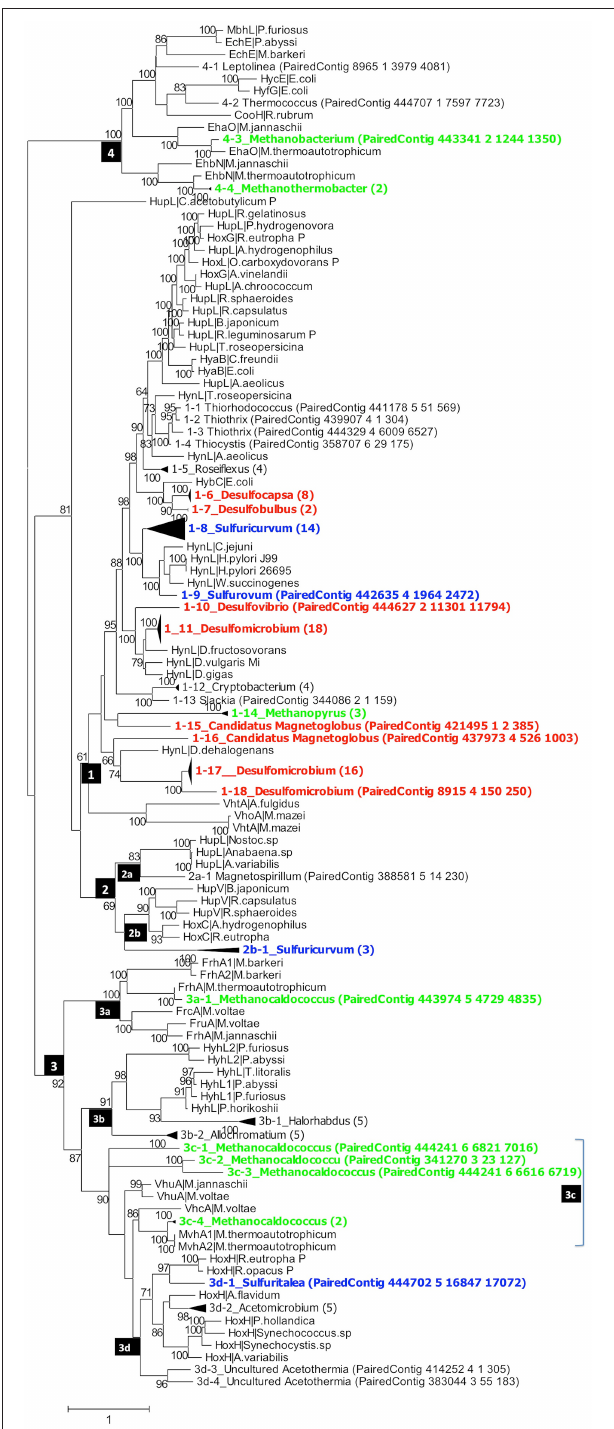
FIGURE 3 | Phylogenetic analysis of putative hynL genes for the large subunit of [NiFe]-hydrogenase detected in the PAS-821TP metagenome. Contigs with high similarity and same taxonomic origin were collapsed into the same clade and the number of contigs in each clade is indicated in brackets. Clades for putative methanogens, SRB,and